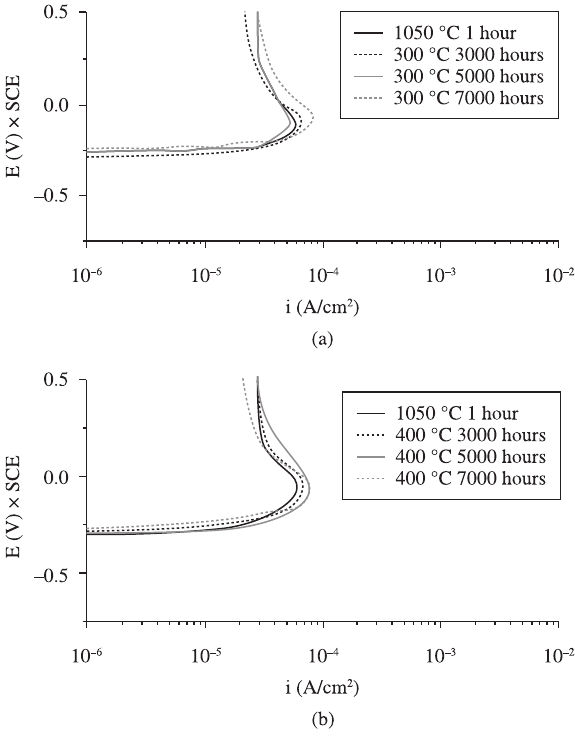
Figure 4. Partial anodic potentiodynamic curves, with the presence of a current density peak of active-passive transition, i under different conditions of time and temperature. Solution: H v = 10 mV/s. a) Aging at 300 ° C and b) aging at 400 ° C.